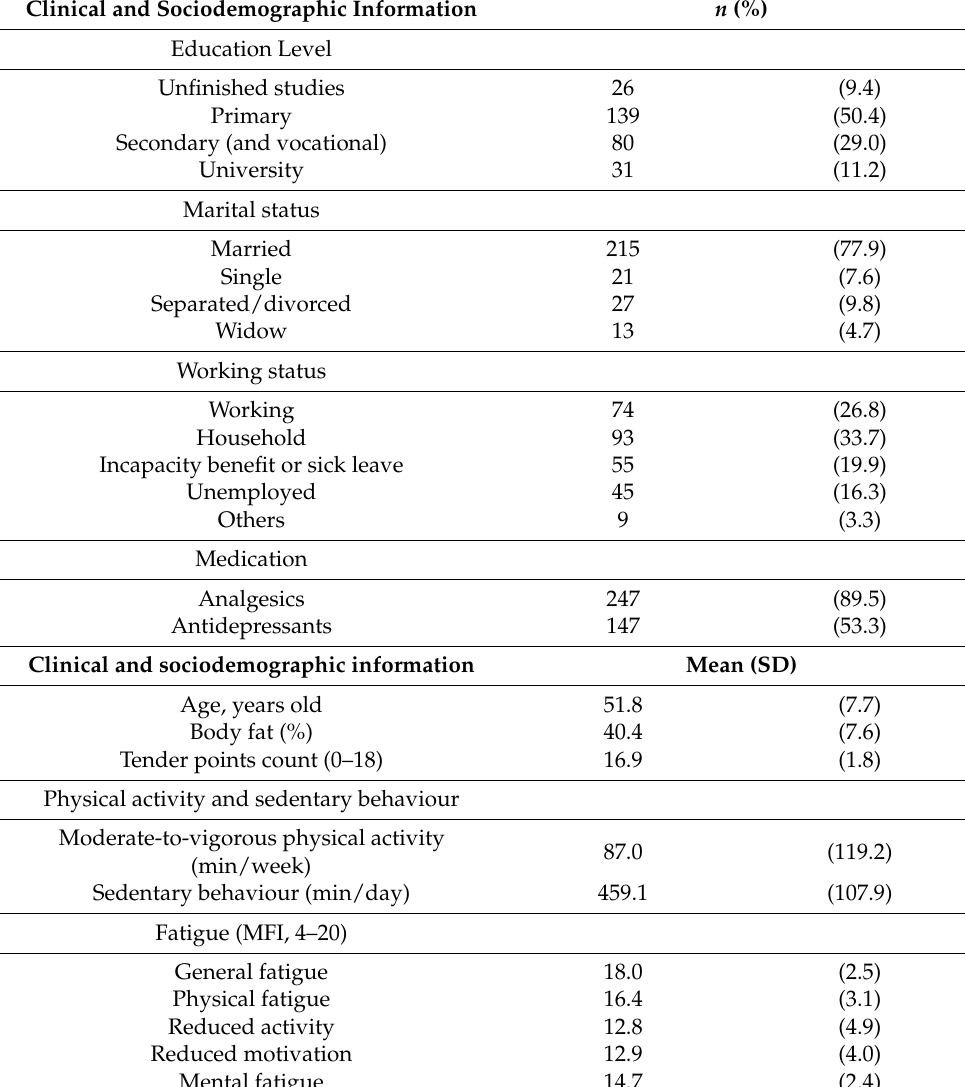
Table 1. Characteristics of the participants in the study, n =